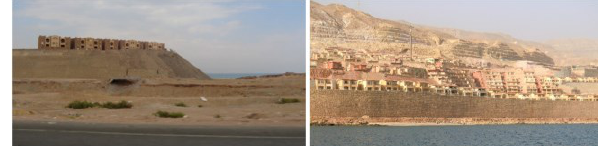
Figure 1. Alteration of the natural environment by touristic resorts. (Source: